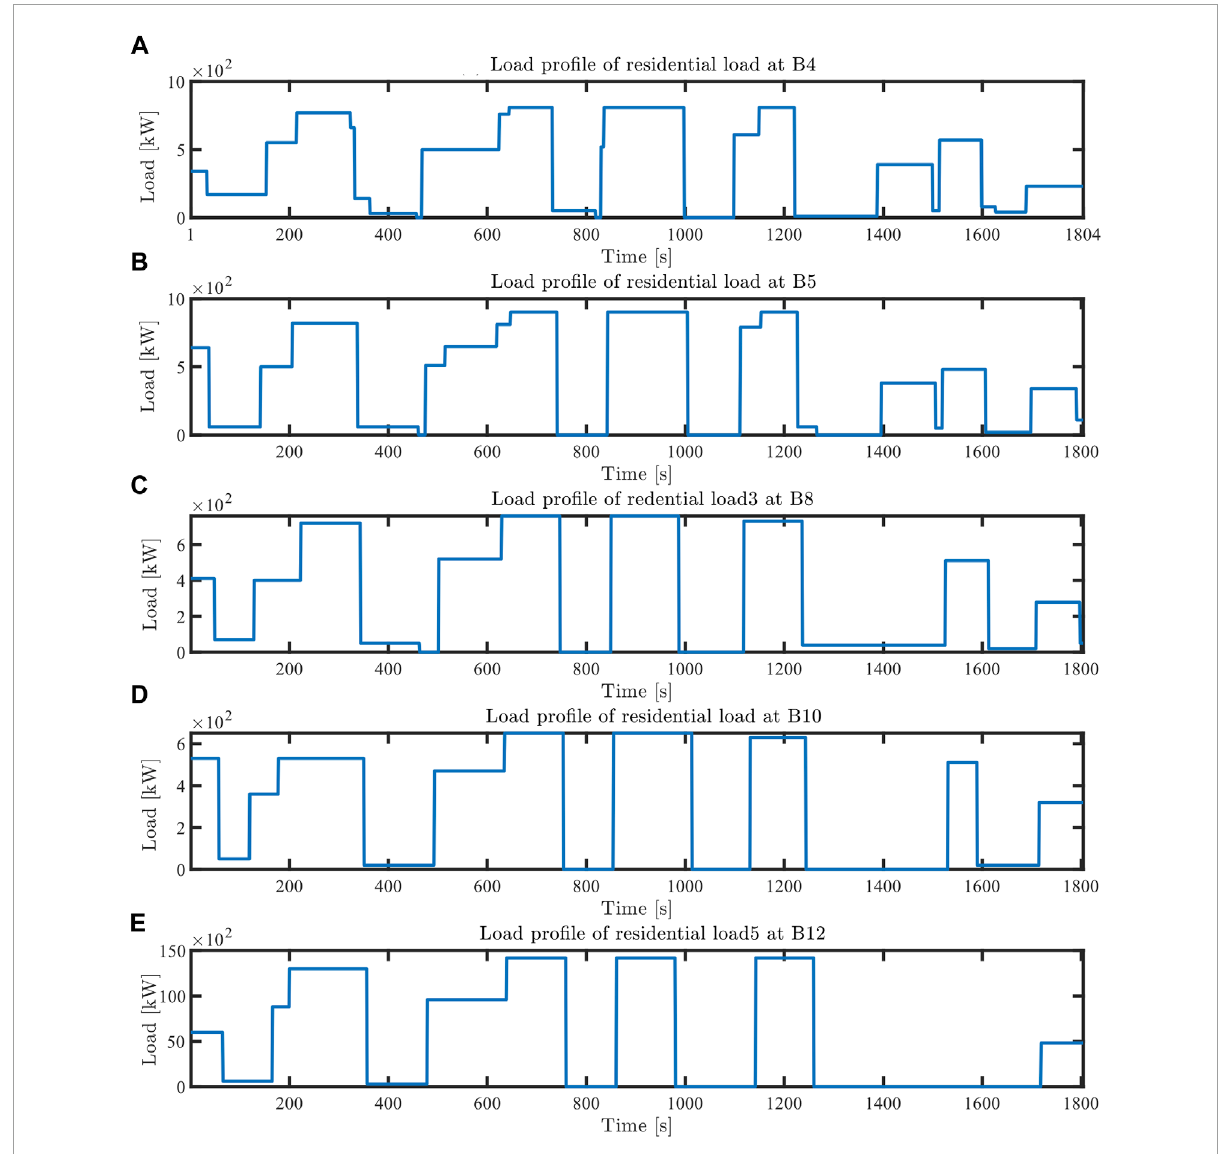
FIGURE 7 Load profile of residential load at (A) B4, (B) B5, (C) B8, (D) B10, and (E) B12.